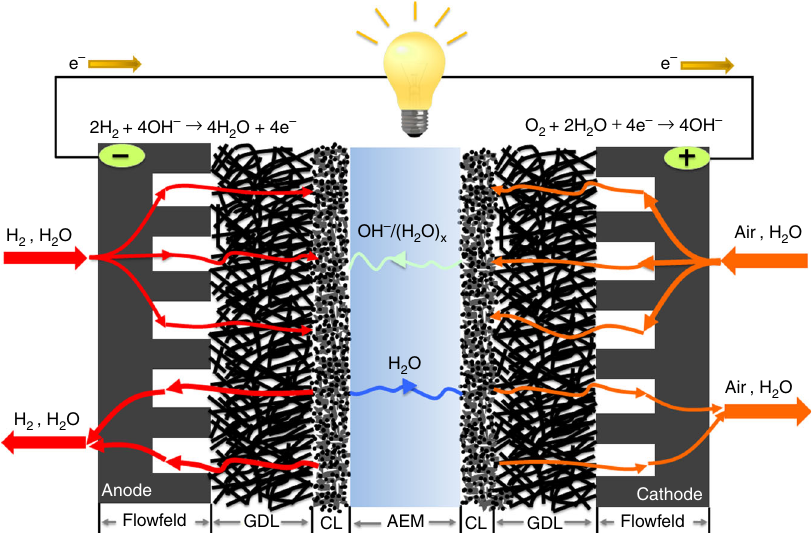
Fig. 1 Illustration of AMFC water dynamics. The mass fl ows and electrode reactions de fi ne the water sources and sinks in an operating AMFC. In the fi gure, AEM = anion exchange membrane, CL = catalyst layer, and GDL = gas diffusion